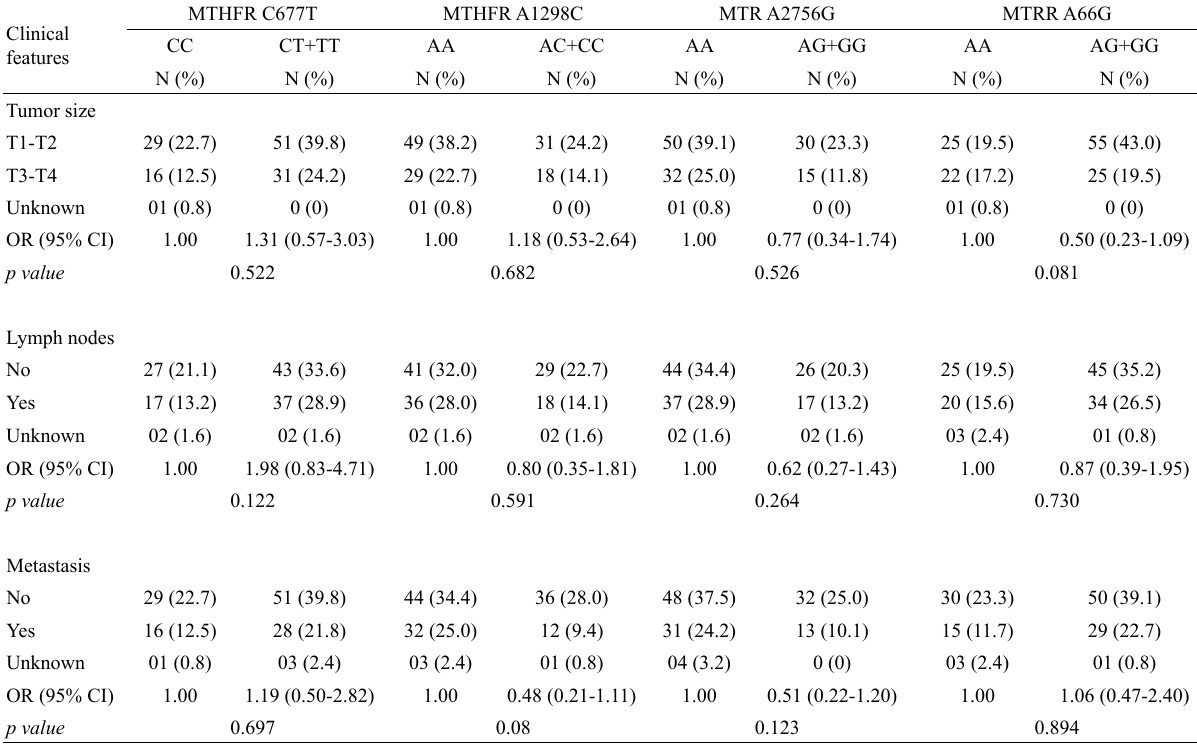
Table 2 ‒ Association between MTHFR C677T, MTHFR A1298C, MTR A2756G and MTRR A66G polymorphisms and clinical tumor size (T1-T2 vs T3-T4), lymph nodes involvement and metastasis.